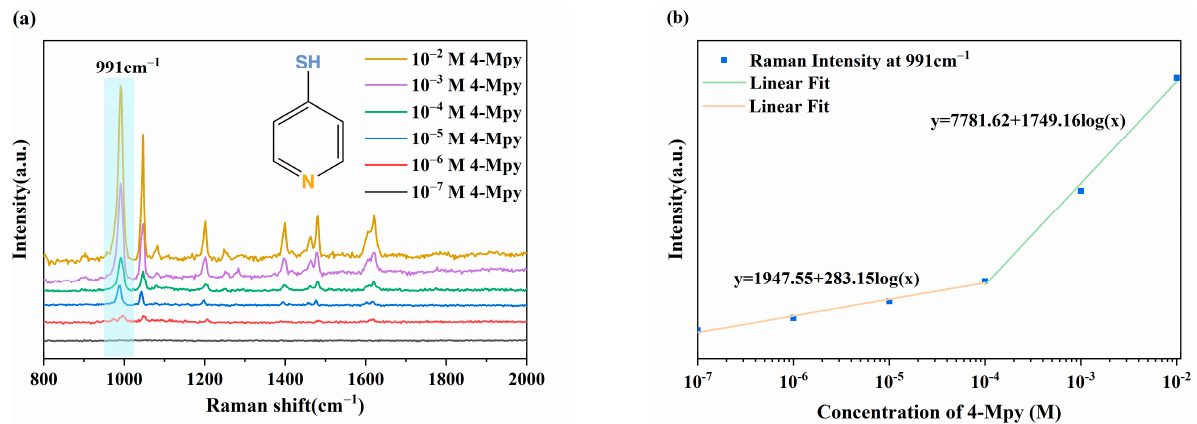
Figure 8. ( a ) SERS spectra of 10 − 2 M 4-Mpy acquired from 10 different spots on the 2%Nd-TiO 2 NPs substrate; ( b ) Raman intensity distribution at 991 cm − 1 from ( a ) for RSD calculation (the average peak intensity is indicated by the red line).